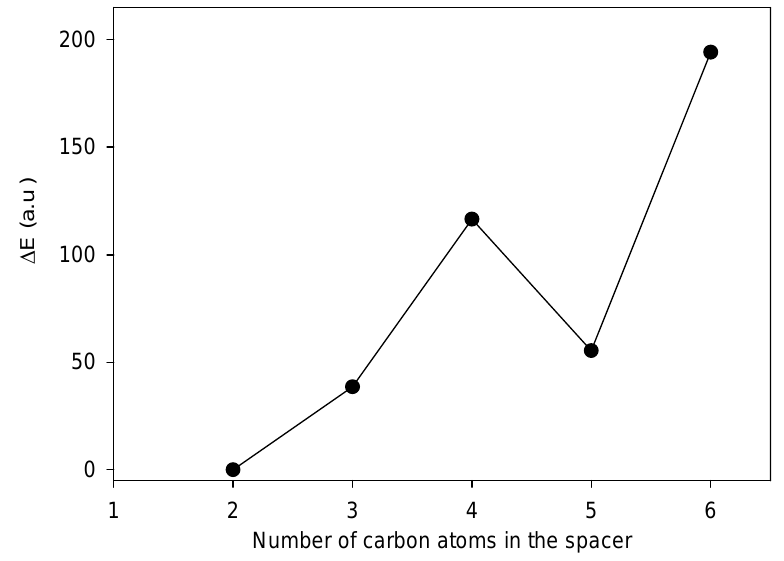
Figure 4 . The relationship between number of carbon atoms in the spacer and relative energy Δ E (a.u.) of 1-5.